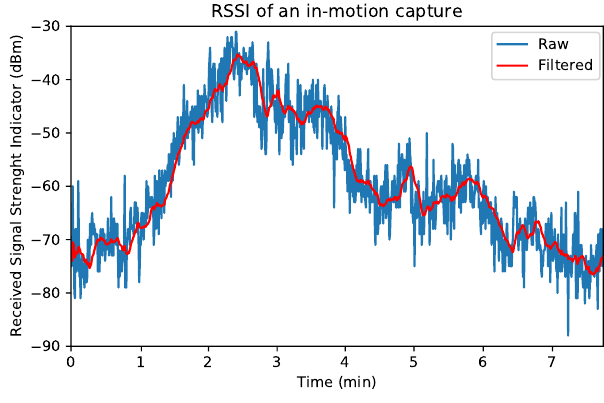
Figure 1. RSSI of a in-motion